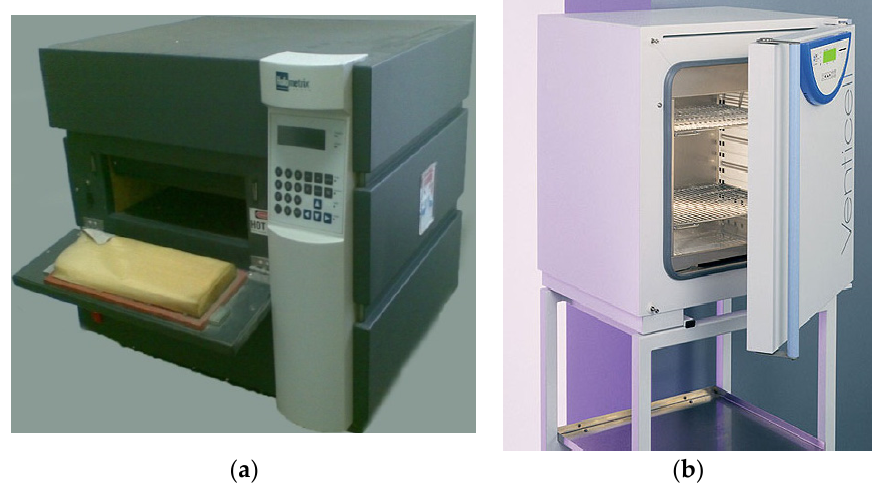
Figure 1. ( a ) Holometrix lambda 2000 equipment; ( b ) Venticell 111 drying apparatus. Table 1. Technical parameters of tested materials. Slentex Protected Vacuum